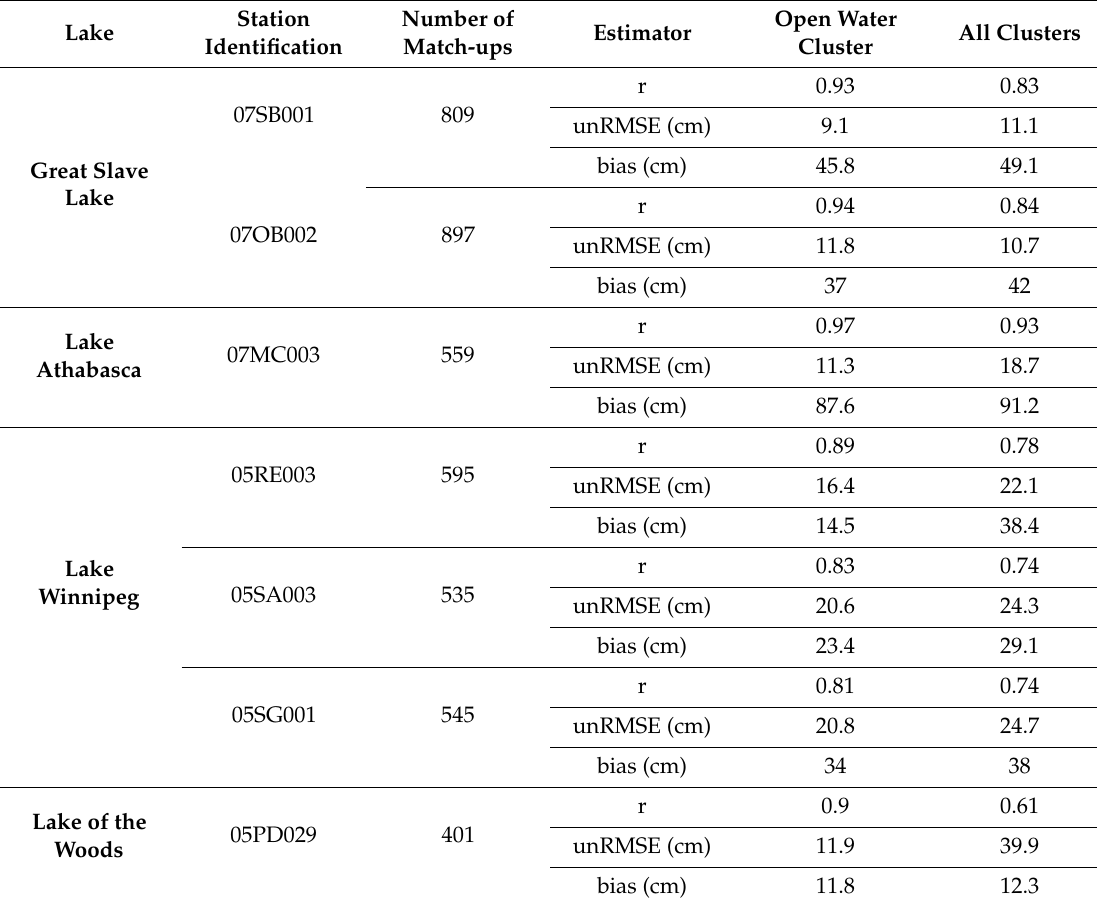
Table 5. Comparisons between altimetry-based water levels and in situ gauge records using Pearson product-moment correlations (r), unbiased root mean-square error terms, and